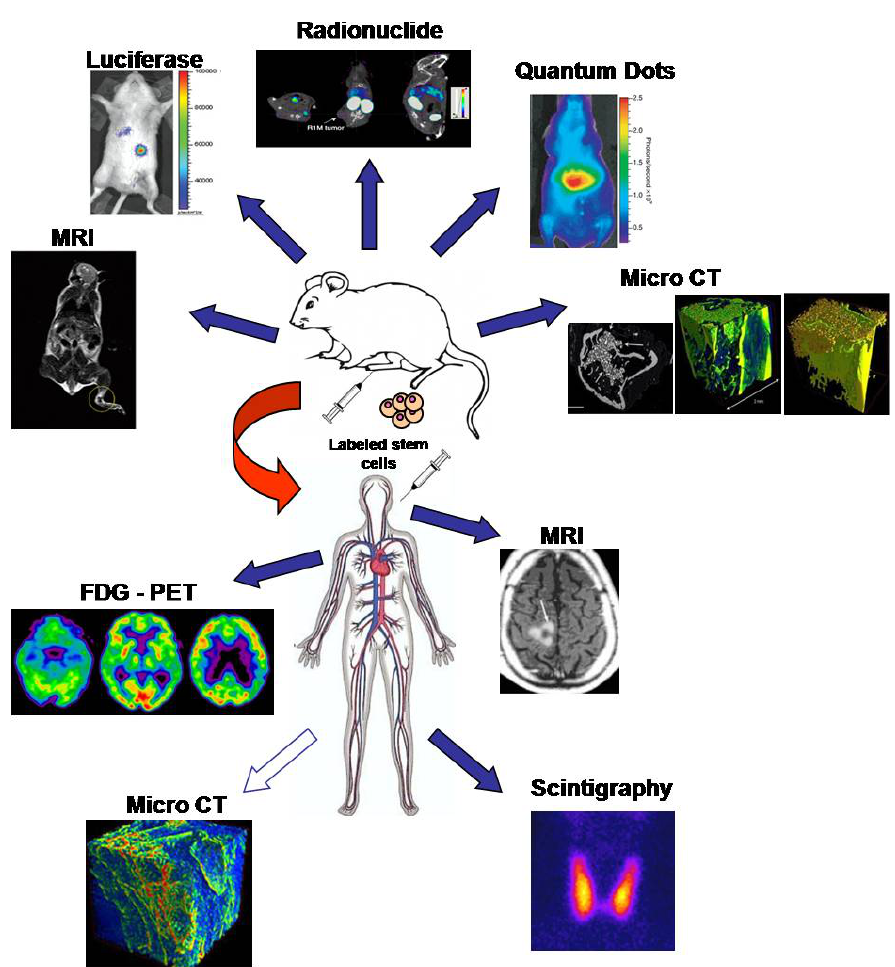
Figure 1. Recent advances in nanotechnology for stem cell tracking. Anatomical and in vivo molecular imaging used to assist researchers in locating labeled stem cell. Methods for tracking stem cells in murine animal model such as MRI [56], MicroCT [17], Luciferase [57], Quantum Dot and Radionuclide [58] are shown in the upper panel. MRI and Radionuclide methods are also used in human studies. Improvement and combination of these methods will allow the quantification of migrating stem cells after their systemic use in clinical trials. In particular the future use of Micro-CT in vivo in humans should complete the need for new tracking methods (white arrow). Website sources for